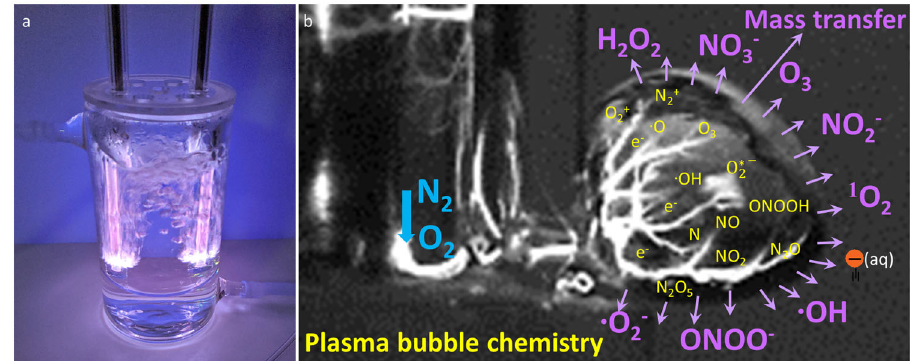
Fig. 2 Example of plasma water reactor. Plasma bubble formation in a water reactor ( a ) and formation of reactive species in a plasma bubble ( b ). When a large number of bubbles form during plasma generation, the mass transfer of active species from the gas (bubbles) to the liquid is signi fi cantly enhanced compared to a plasma discharge at the surface of the liquid. This process leads to higher activity of the resulting